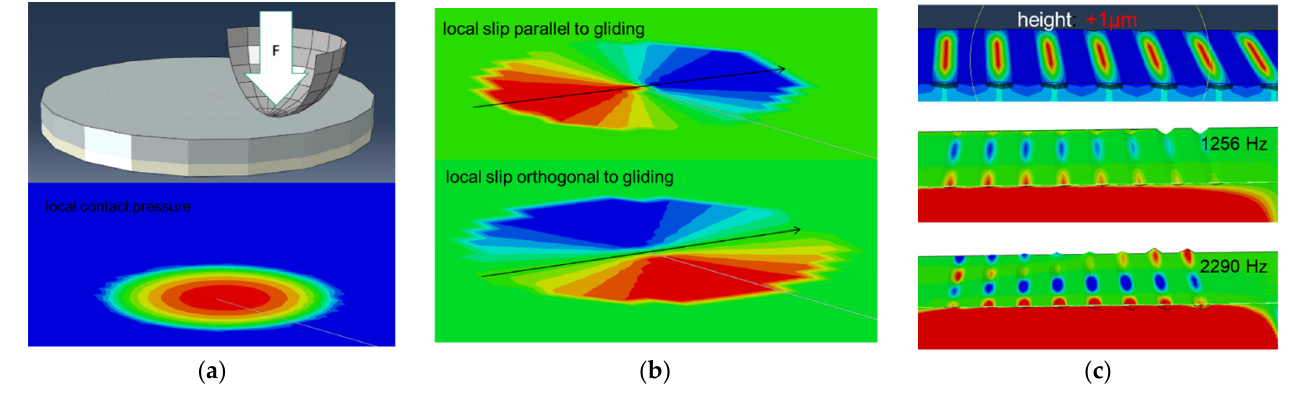
Figure 7. Loading situation of friction test with a ball on a plate: ( a ) Each plate is loaded with a normal force that produces broad contact pressure distribution due to the hyperelasticity of LSR. ( b ) Macroscopic gliding and hyperelastic deformation result in a 2D slip situation. ( c ) A modal analysis of the groove structure in contact reveals a secondary deformation in height caused by flattening but a frequency-dependent deformation in the gliding direction caused by groove opening–closing cycles.